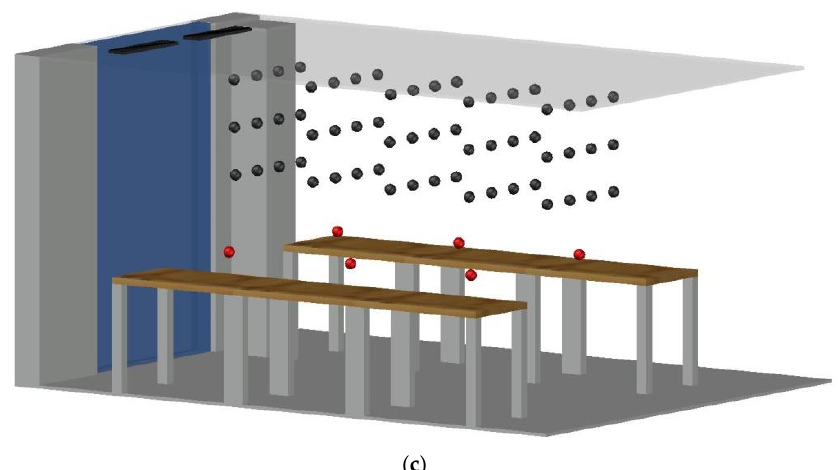
Figure 3. The location of the measuring probes: ( a ) vertical section; ( b ) horizontal section; ( c ) three-dimensional view: black points — AirDistSys 5000; red points — microclimate meter.